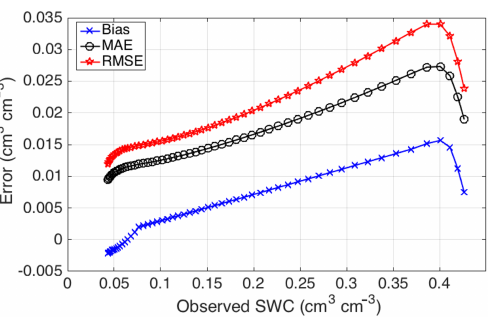
Figure 6. Propagation of error analysis using Monte Carlo simu- lations of 100000 soil parameter datasets of true soil parameters (i.e., soil bulk density, lattice water, soil organic carbon) and per- turbed parameters with matching mean differences and covariance matrix between in situ samples and GSDE-derived parameters (see Table 2). Three error metrics are presented across a range of neu- tron counts (and thus SWC values). Note that soil bulk density was constrained to 1.2–1.5gcm − 3 , lattice water from 1 to 8wt%, soil organic carbon from 0 to 8wt%, and soil water content from 0.03 to 0.45cm 3 cm − 3 . Simulated and calculated values outside of these bounds were either reset to the minimum or maximum or removed from the Monte Carlo statistics. A minimum threshold of 70% of simulated cases was used to compute error statistics.